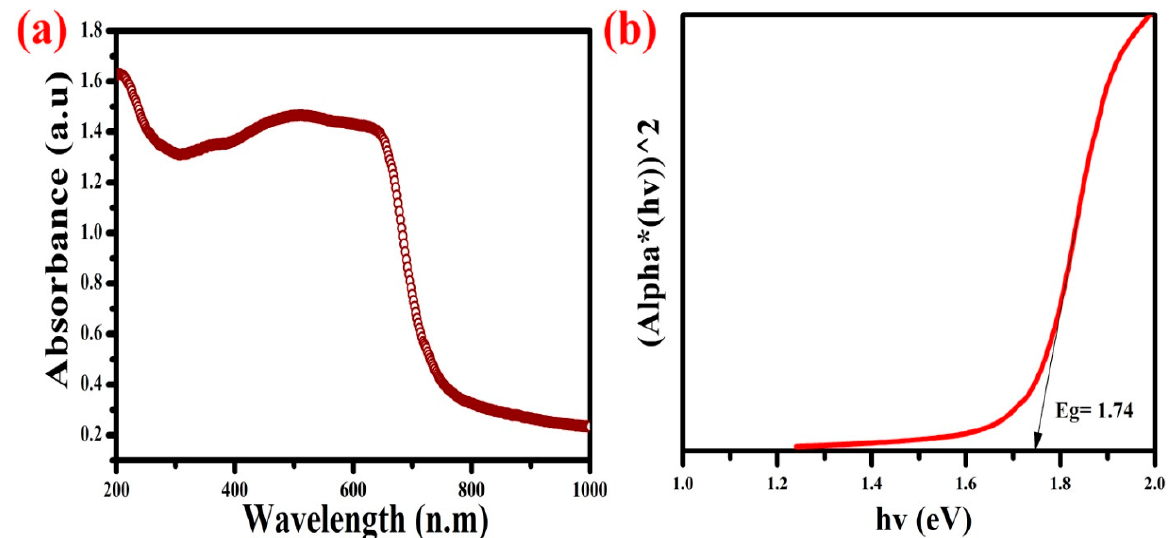
Figure 1. UV-DRS optical absorbance ( a ) and bandgap ( b ) spectra of green synthesized NiSe NPs.